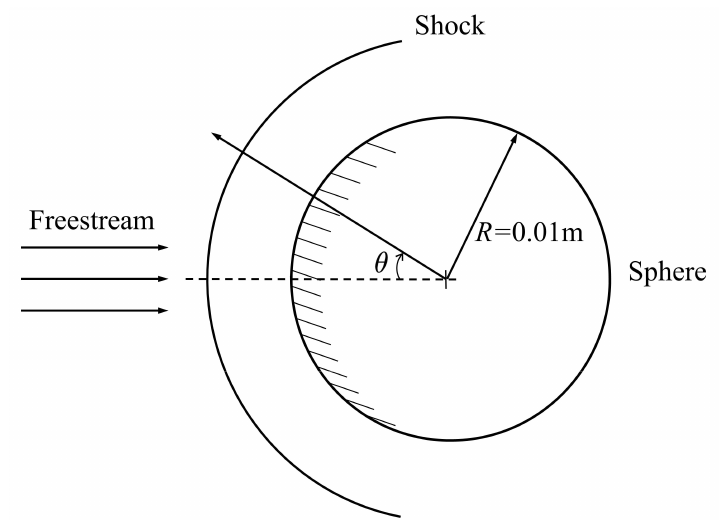
Figure 4. Schematic diagram of Bush’s